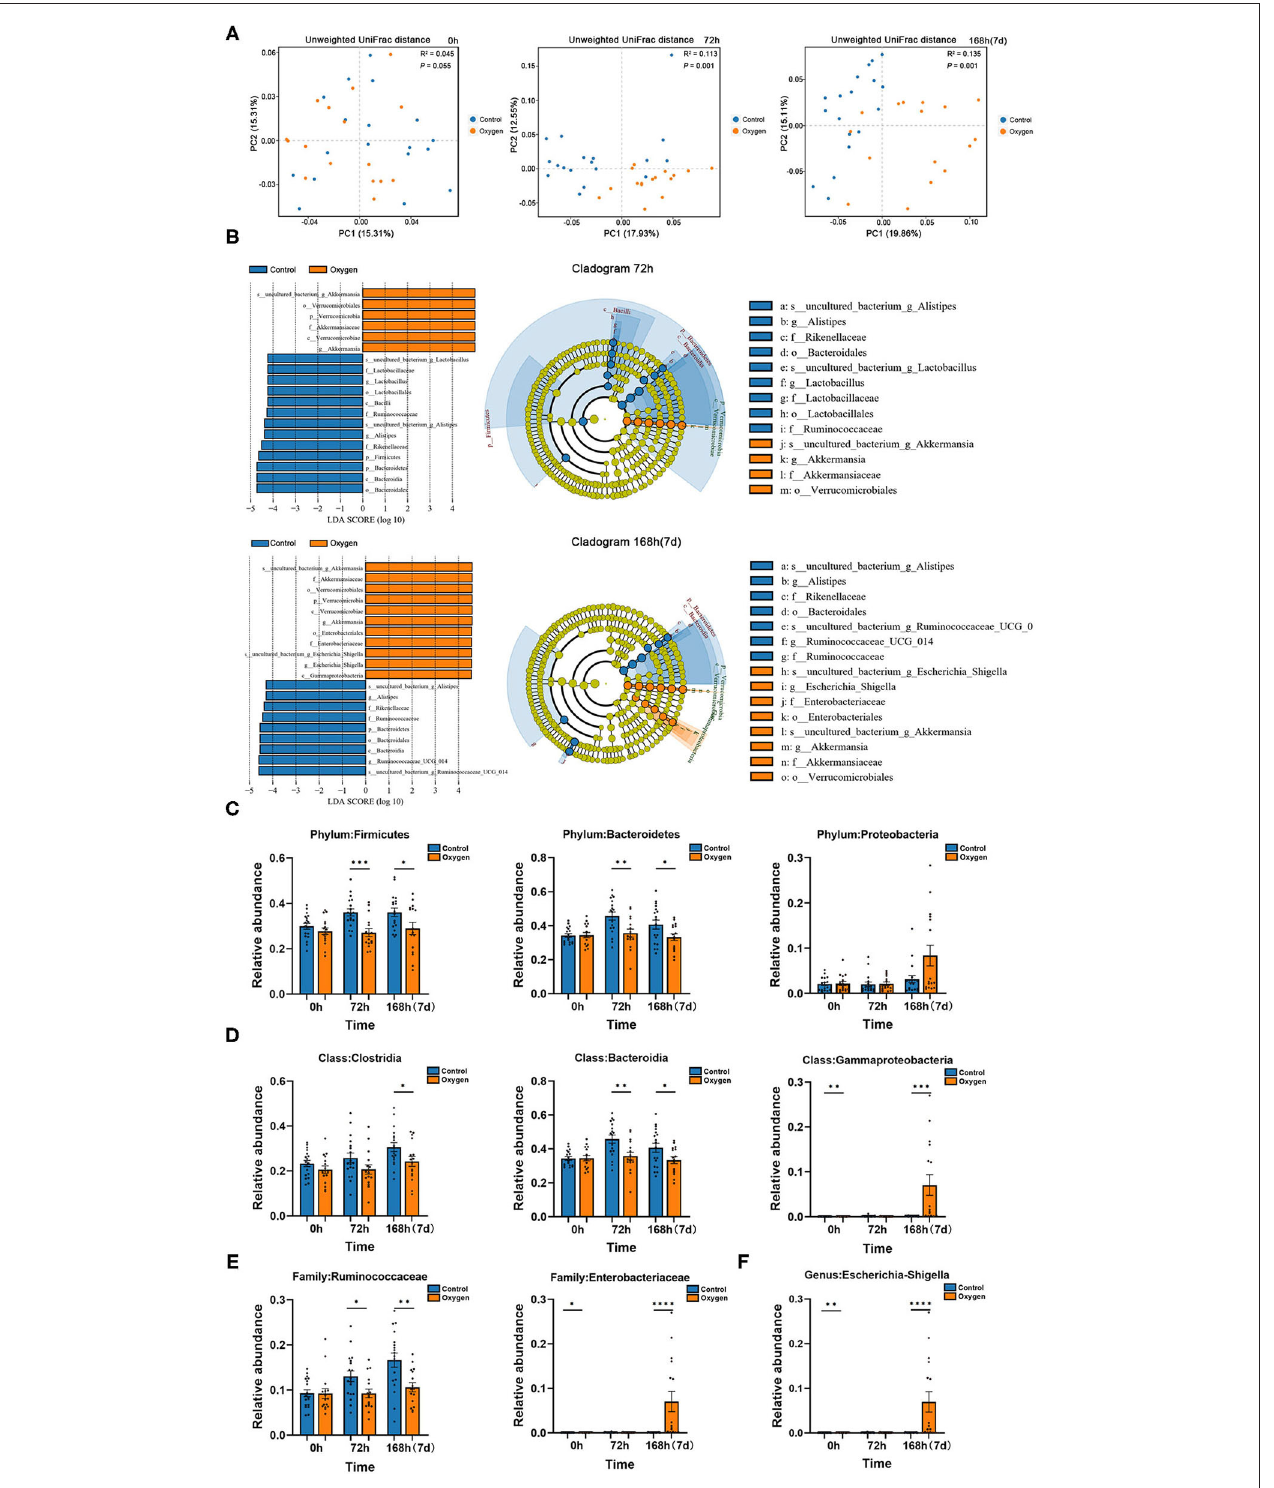
FIGURE 5 | Hyperoxia alters gut microbiota in mice. (A) PCoA plots of the control groups ( n = 18) vs. the oxygen groups ( n = 16) at 0, 72, and 168h (7 days) based on Unweighted UniFrac distances. (B) LDA along with effect size measurements was applied to the enriched bacteria from the genus level to the phylum level in the control and oxygen groups at 72h and 7 days, respectively. (C–F) The detailed comparison of the biomarkers of taxonomy in the control and oxygen groups at different time points (0, 72h, and 7 days) at the Phylum, Class, Family, and Genus level, respectively. PCoA, principal co-ordinates analysis; LDA, linear discriminant analysis. * P < 0.05; ** P < 0.01; *** P < 0.001; **** P < 0.0001.